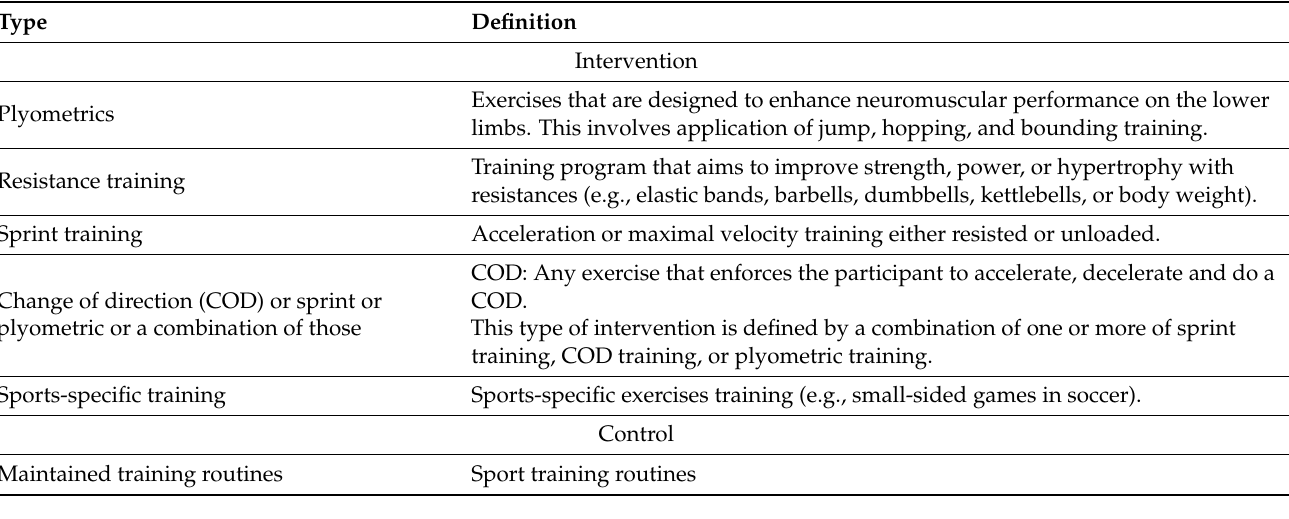
Table 1. Definition of types of interventions and